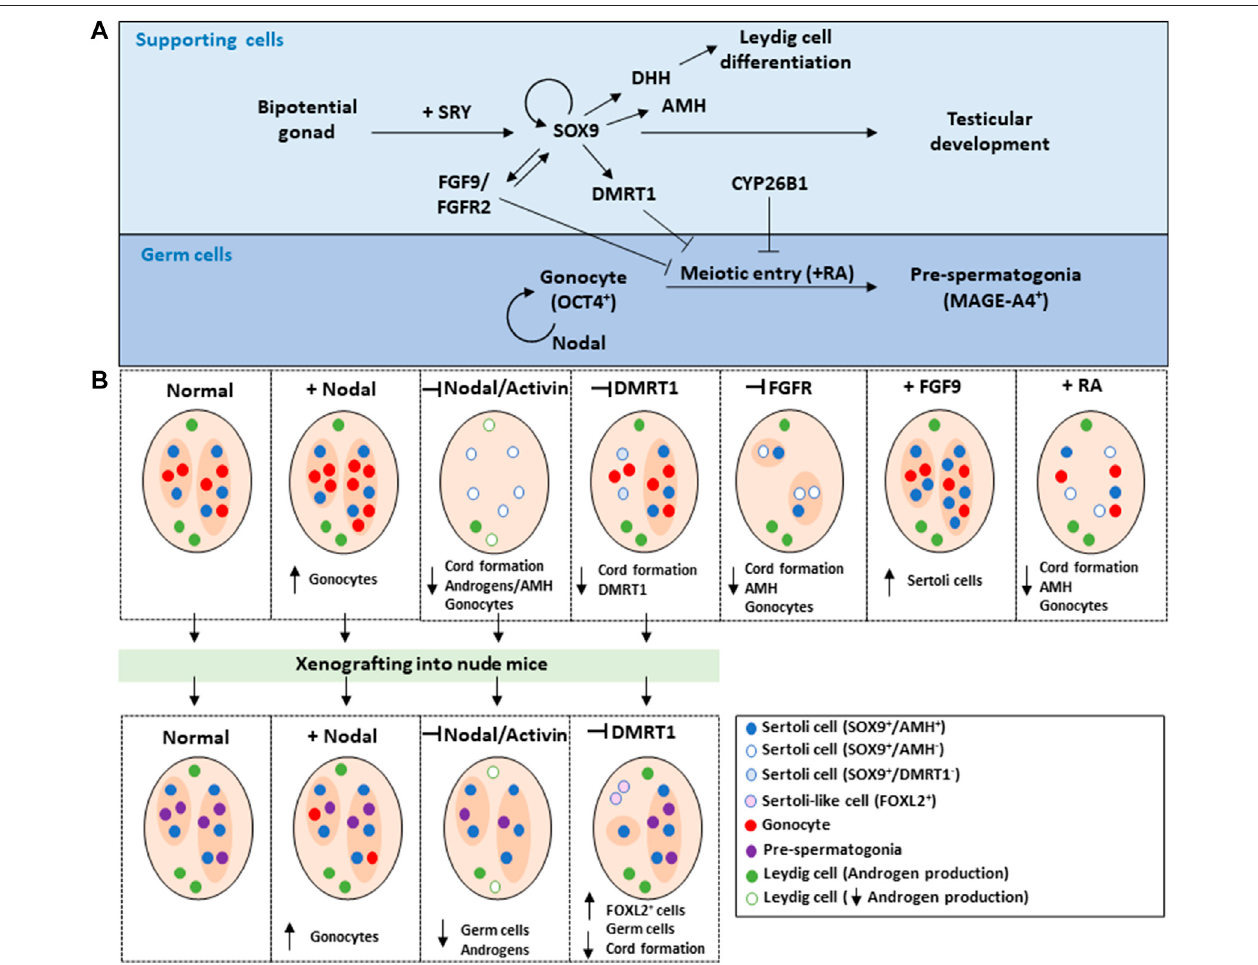
FIGURE2| Currentunderstandingofthesex-speci fi cdifferentiationofhumanfetaltestesbasedoninformationfrommousemodels,patientswithDisordersofsex development and ex vivo culture models. (A) In the bipotential gonad of a XY (male) embryo, SRY is upregulated in the supporting cells and induce the expression of SOX9 which together with FGF9/FGFR2 promote the differentiation of the supporting cell lineage into Sertoli cells. AMH expressed by the Sertoli cells further supports maledevelopmentofthefoetusbyensuringregressionoftheMüllerianducts.TheSertolicellsstimulatesthedifferentiationofthesteroidogeniccelllineages(Leydig cells) through paracrine signalling mediated by DHH. Additionally, the Sertoli cells directs the germ cell commitment to the male developmental pathway by repressing meiotic entry through the actions of CYP26B, FGF9/FGFR, and DMRT1, while Nodal signalling is involved in regulating germ cell pluripotency and thus the regulation of gonocytetopre-spermatogoniadifferentiation. (B) Illustrationandsummaryof fi ndingsfromthemanipulationofselectedsignallingfactorsin exvivo culturedhumanfetal testes, whichinsomecasesincluded manipulations in exvivo cultureofhumantestesfollowedbyxenograftingintonudemicetoexaminelong-termeffects.References to the studies included in the fi gure can be found in the